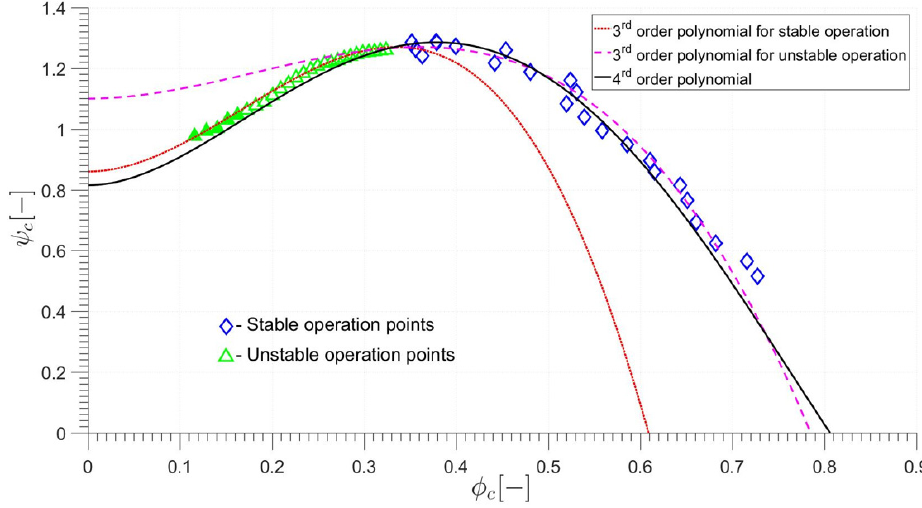
Figure 4. Analysed compressor performance curves.